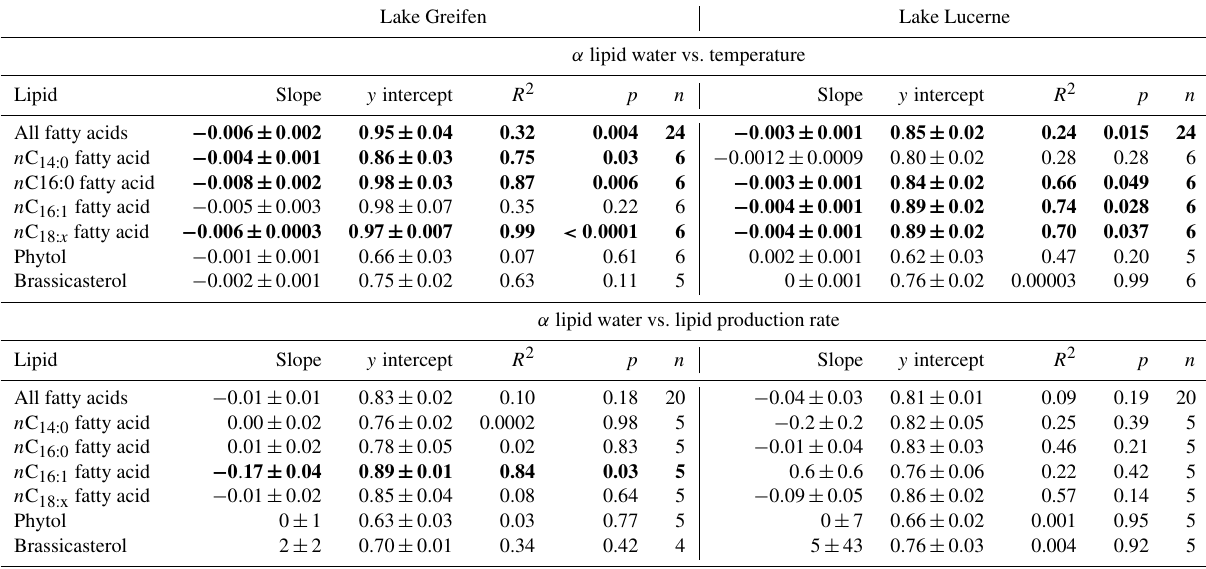
Table 2. Summary of linear regression statistics; bolded relationships are significant at the p < 0 . 05 level. Lake Greifen Lake Lucerne α lipid water vs. temperature Lipid All fatty acids